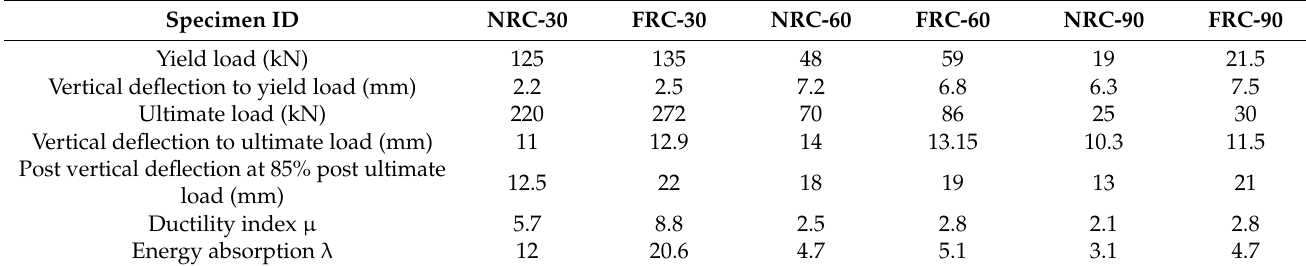
Table 8. Compressive stiffness and flexural stiffness of specimens.